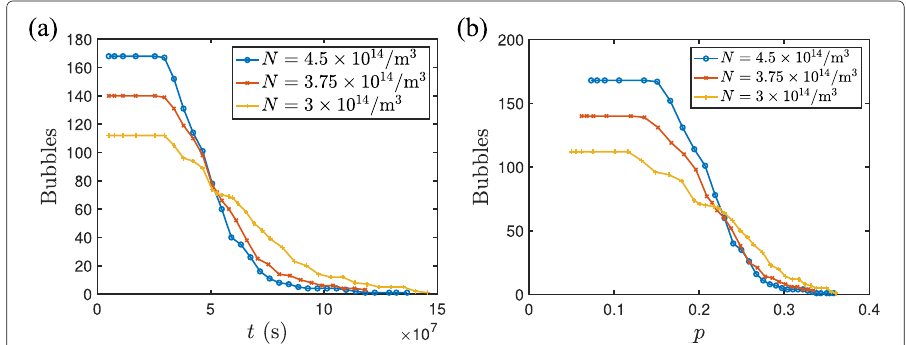
Fig. 6 Number of bubbles for varying initial bubble number density